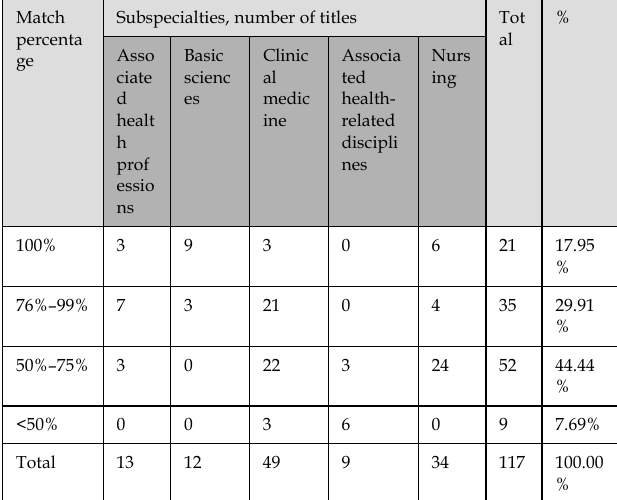
Table 1 Match percentage of subspecialties to DCT 2018